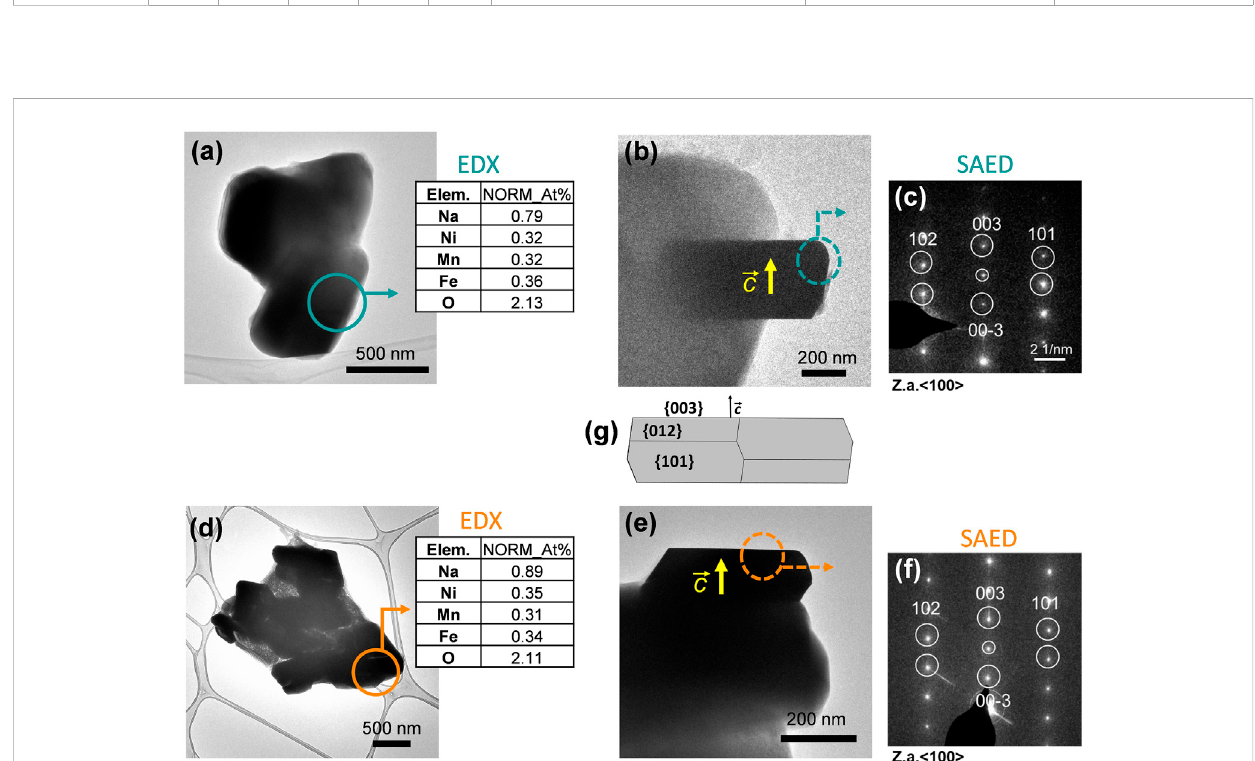
FIGURE 2 TEM images of the characteristic particles, EDX measurements and SAED patterns for (A – C) O3-NaNMF-SS and (D – F) O3-NaNMF-SG. Selected areas, where EDX measurements and electron diffraction patterns have been carried out, are highlighted. EDX quanti fi cations are presented in atomic percentages and the values are normalized with respect to the values of Ni, Mn, Fe (G) The simulation of the habit of the particles.